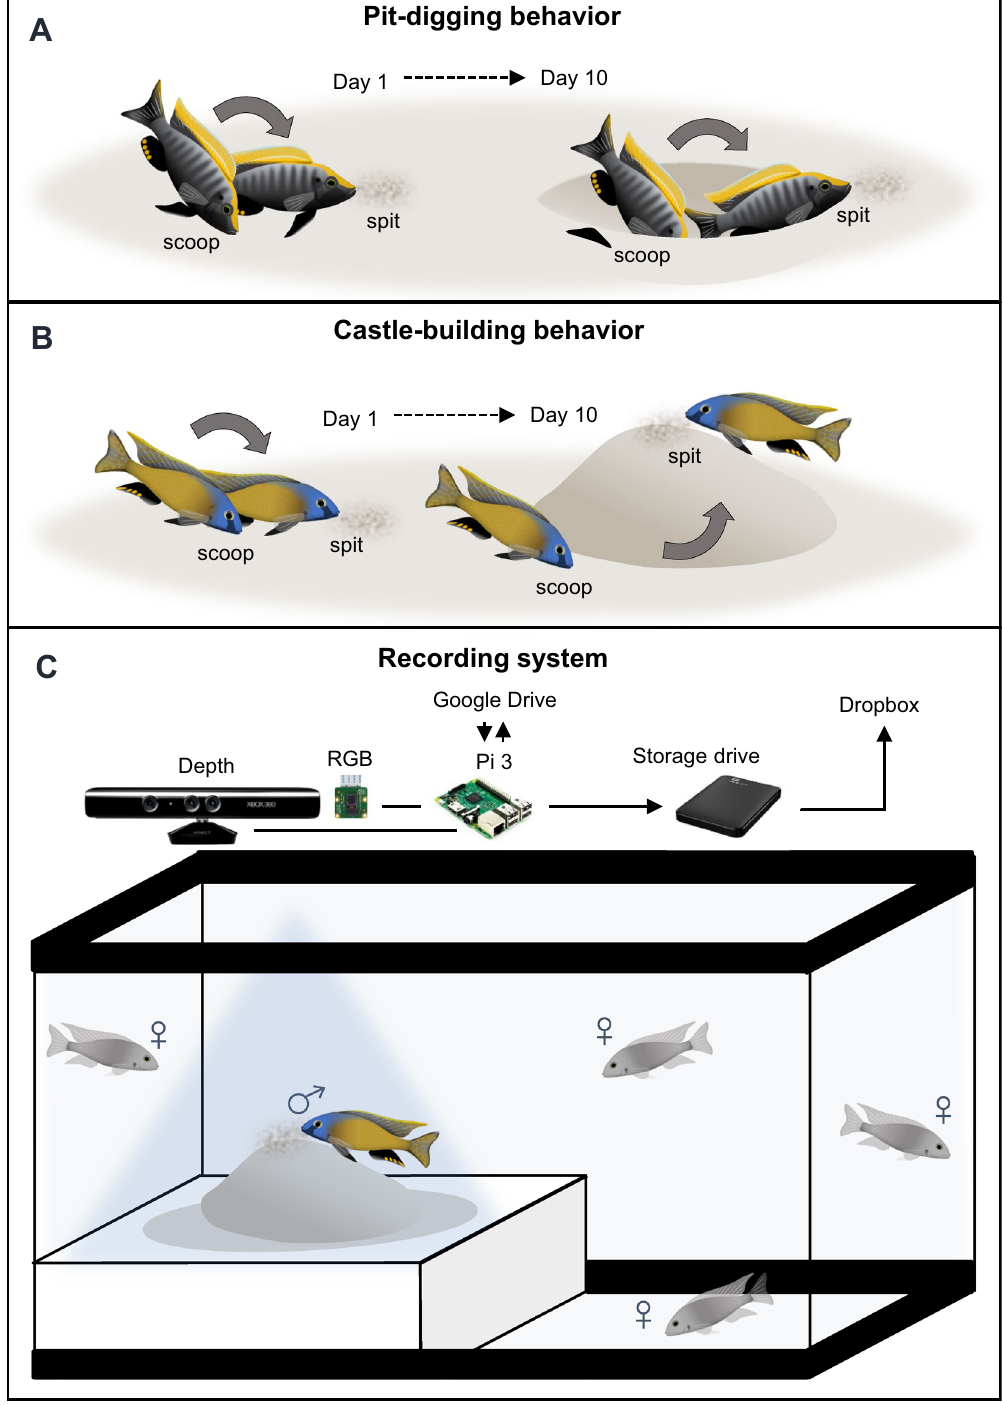
Figure 1. An automated recording system to measure bower behaviors in laboratory aquariums. Bowers are constructed over the course of many days ( A , B ). Pit-digging involves scooping sand from a concentrated region and spitting it into dispersed locations (( A ), representation of a Copidachromis virginalis male digging a pit). Castle-building involves scooping sand from dispersed locations and spitting it into a concentrated region (( B ), representation of a Mchenga conophoros male building a castle). To measure bower behaviors, we developed a behavioral assay and an automated recording system for standard laboratory aquatics facilities ( C ). A reproductive adult male is introduced to a 50-gallon aquarium tank containing a sand tray and four reproductive females. The recording system utilizes a Raspberry Pi 3 computer connected to a high-definition RGB camera and a Microsoft Kinect depth sensor for video recording and depth sensing, respectively. Data is stored on an external hard drive and uploaded to Dropbox. The system is remotely controlled by custom Python scripts and a Google documents